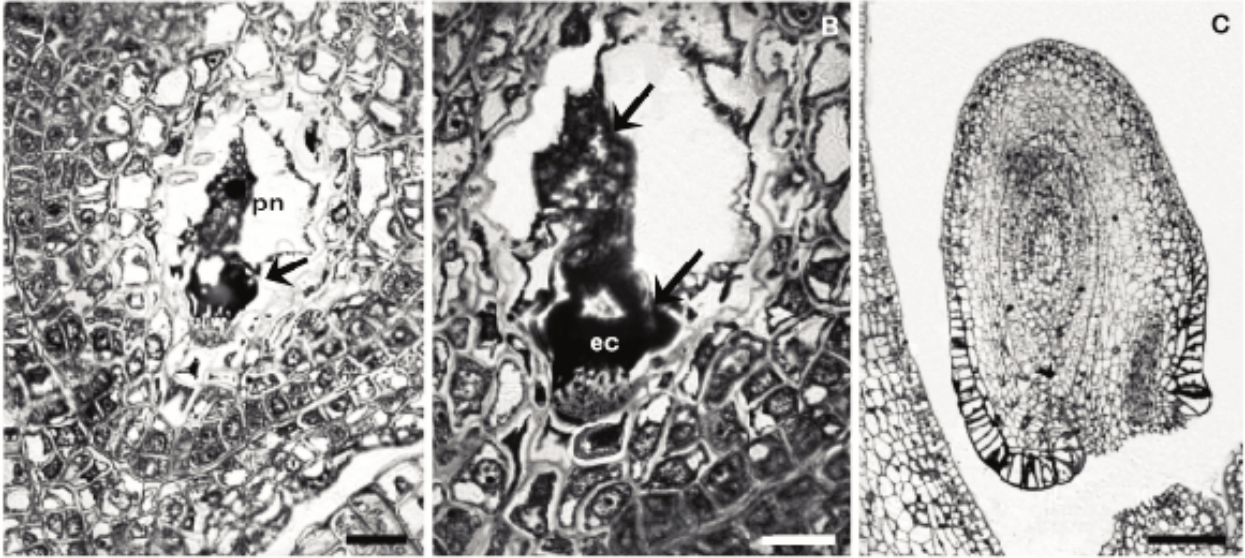
Fig. 7 -Fertility of B. microphylla G. Forst. A-B, time of discharge of sperm nuclei (arrows) into the egg cell (ec) and polar nuclei (pn), C, growing seed. Bars: A-B= 200 µm; C= 100